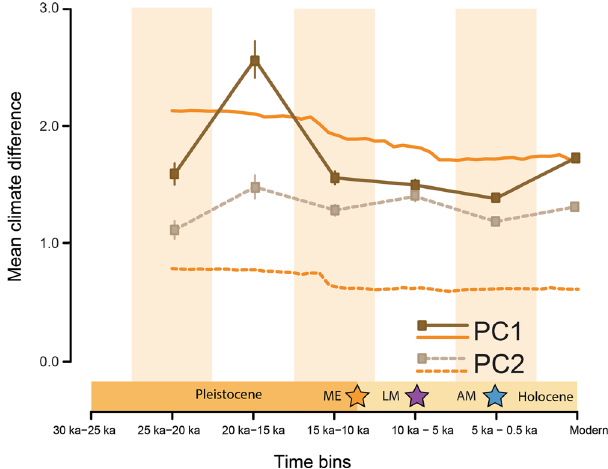
Fig. 2 Mean climate difference between bins does not decrease during the intervals for which we observe biotic homogenization (sample sizes in Source Data). Change in climate turnover (mean climate difference) ± the standard error of the mean. Climate estimates are based on de-biased and downscaled earth system model (ESM) climate simulations from recent and paleoclimate models at 0.5 degree resolution 68 . The orange star indicates the extinction of the mammal megafauna in North America (ME). The purple and blue stars indicate points at which assemblages of large mammals (LM) and all mammals (AM) were more homogenous that null expectations. The lines in brown tone indicate climate rasters sampled at the same locations as the fossil and archeological sites included in the study. The lines in orange tone represent sampling of the climate rasters are equal intervals across the landscape between 35 and 80 ˚ N based on the fact that the majority of the fossil and archeological sites included in the present study occur between these